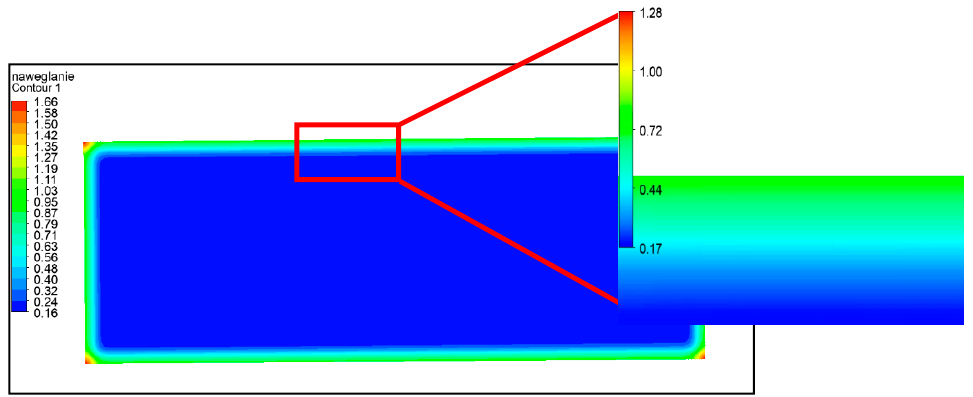
Figure 4. Carbon concertation distribution on a planar section.